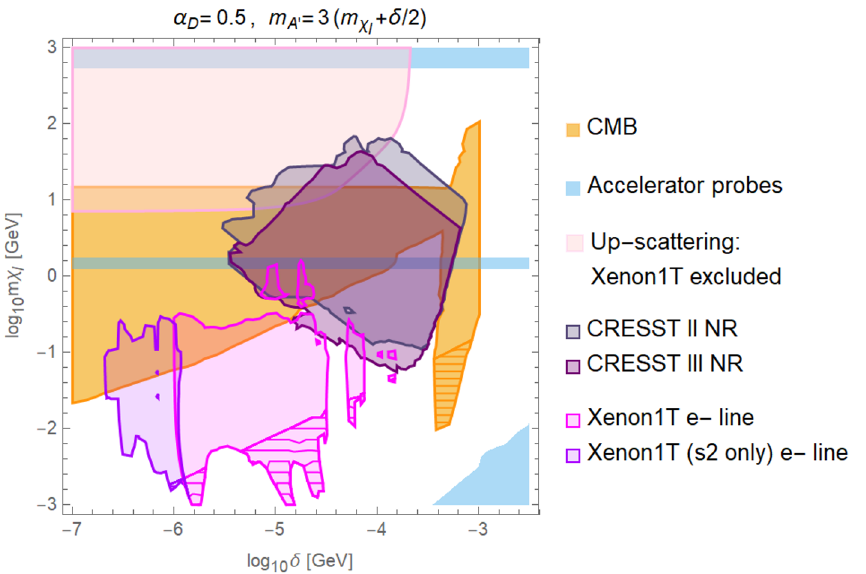
Figure 9 . Detailed exclusion regions for direct detection probes, with summary of CMB and accelerator-based constraints for α = 0 . 5 and m = 3 ( m + δ/ 2) . In mustard and light blue, D A 0 χ l we observe the regions of parameter space ruled out by CMB observations and collider probes respectively. The fair pink region is ruled out by the absence of an up-scattering signal in Xenon1T search window from [74]. The dark purple diagonal regions correspond to the constraints due to the lack of nuclear recoil (NR) signals in CRESST II and CRESST III. Lastly, the sub-GeV regions in magenta shades are ruled out by the absence of the electron recoil signals in Xenon1T. Note that the striated regions for both the CMB and direct detection exclusions correspond to areas where semi-elastic interactions could further deplete the excited state abundance and weaken the constraints. Analogous plots for additional dark-sector benchmarks are shown in figure